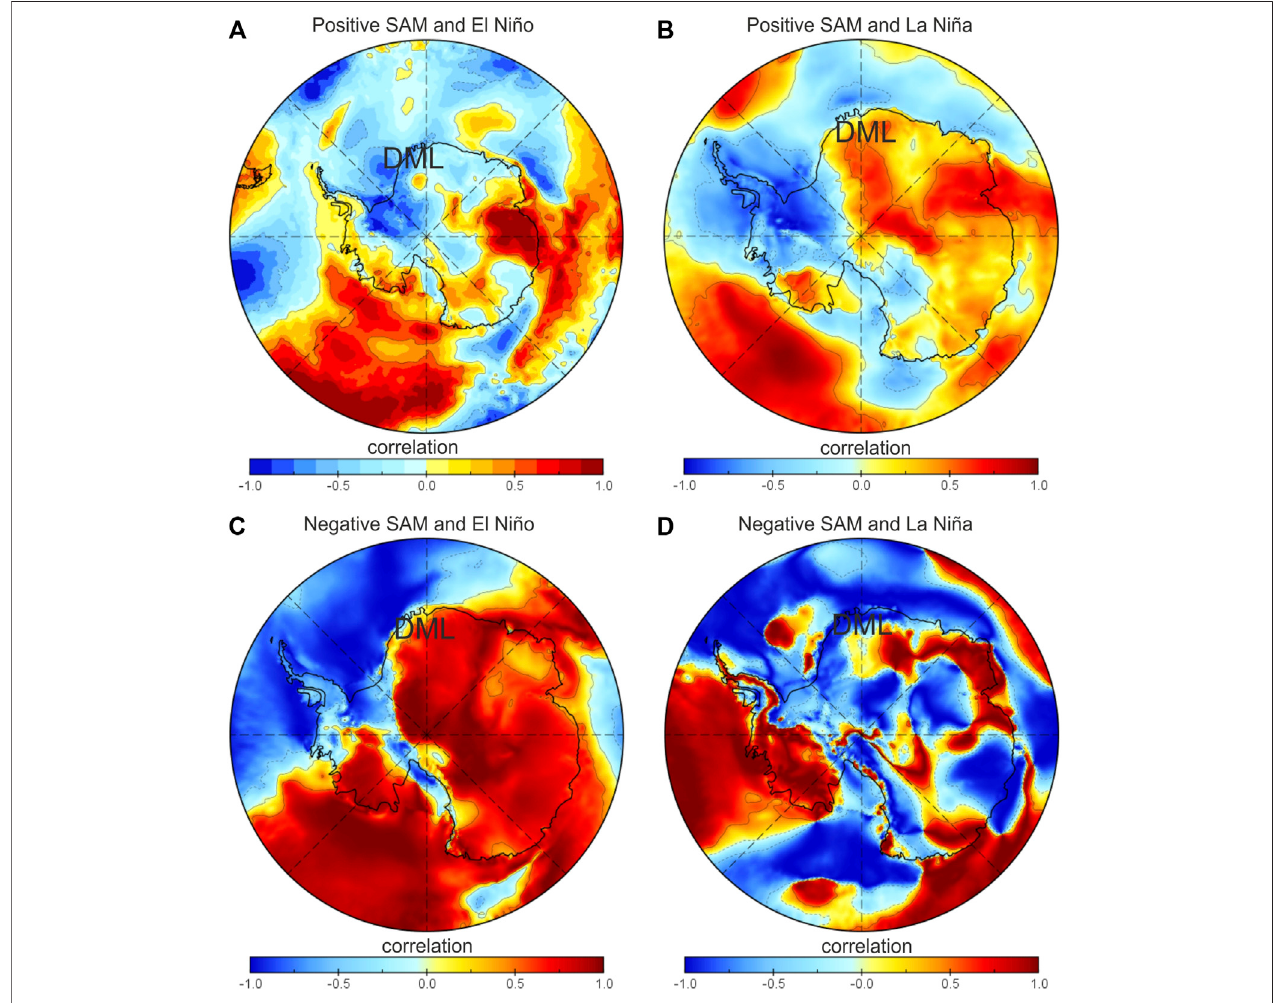
FIGURE9| Meansealevelpressure(MSLP)duringthepositiveSAM(pSAM)yearsiscorrelatedwithERA5surfaceairtemperature during (A) ElNiñoyearsand (B) La Niña years. MSLP during the negative SAM (nSAM) years is correlated with ERA5 surface air temperature during (C) El Niño years and (D) La Niña years.